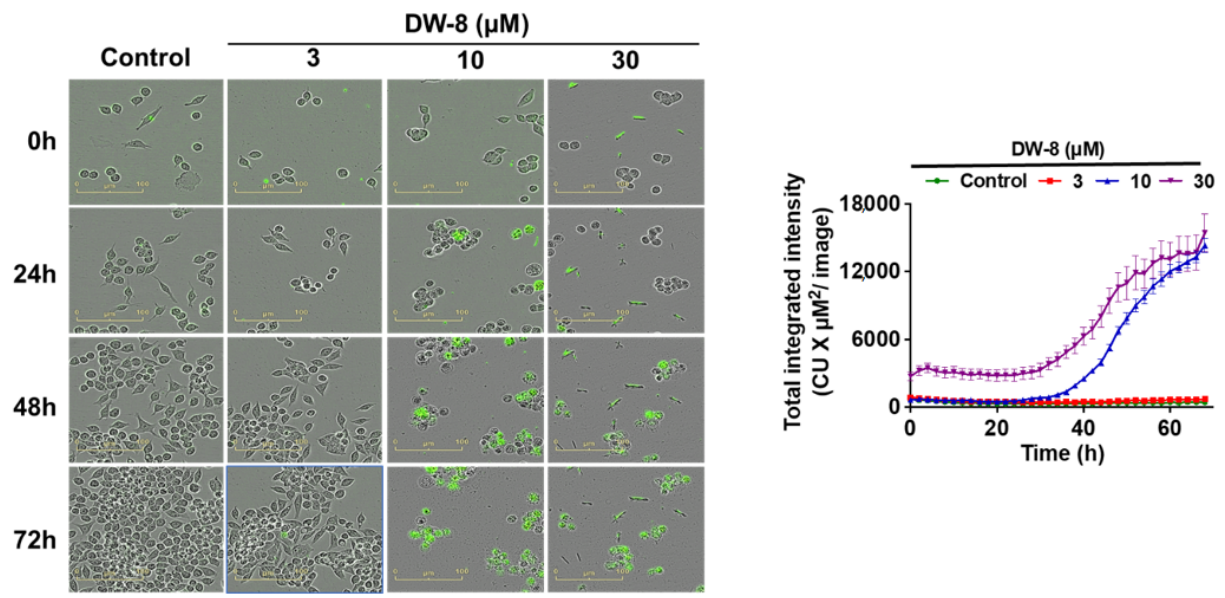
Figure 5. Incucyte images of SW620 cells incubated with the vehicle (negative control), 3, 10, and 30 µM of DW-8 for 72 h, followed by staining with Incucyte Cytotox Green. The green fluorescence was significantly increased by 10 and 30 µM of DW-8 , compared to cells incubated with the vehicle or 3 µM of DW-8 . The data represent means ± SD of three independent experiments performed in triplicate.